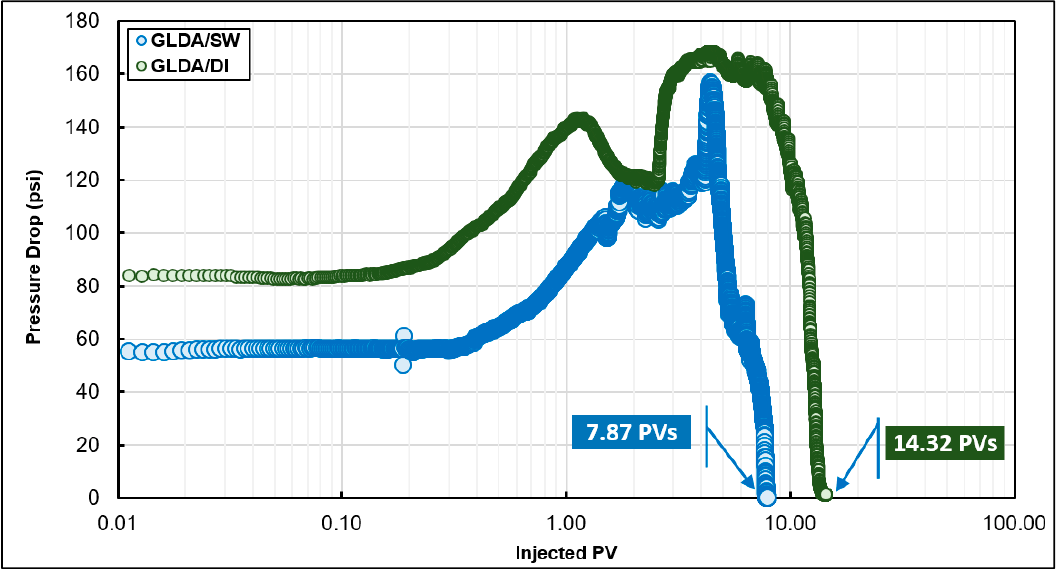
Figure 16. Pressure drop variation during injection of 20 wt% GLDA/SW (pH = 3.8) at 250 °F at 0.25 cm 3 /min compared to 20 wt% GLDA/DI at pH of 3.8 in 6.0 inches of Indiana limestone.